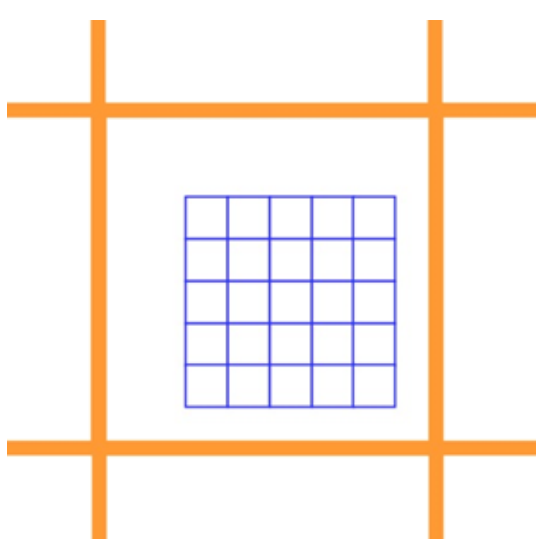
Figure 7. Example of projection before the border is added.